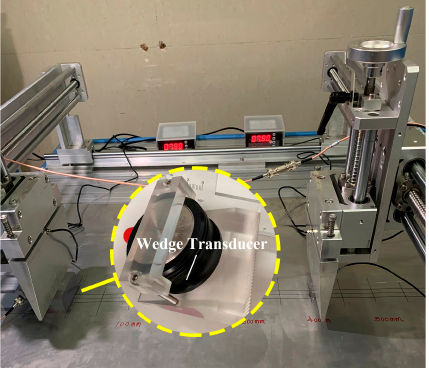
Figure 8. A designed fixture to ensure the collinear arrangement of transmitters and receivers, and maintain the constant contact pressure between two wedge transducers and plates.